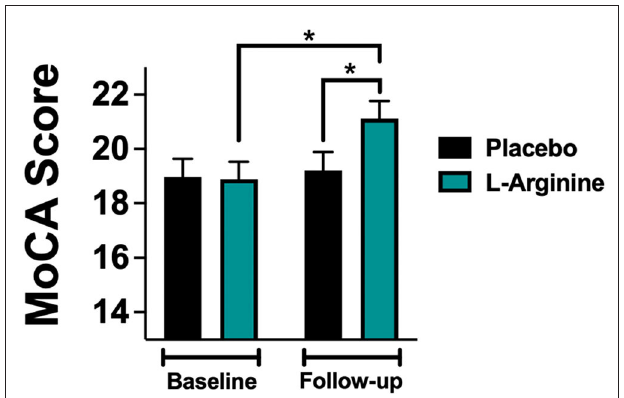
FIGURE 2 | MoCA (Montreal Cognitive Assessment) score evaluated at baseline and at follow-up in the placebo and in the L-Arginine arms. Data are means ± SE; *: p < 0.05.